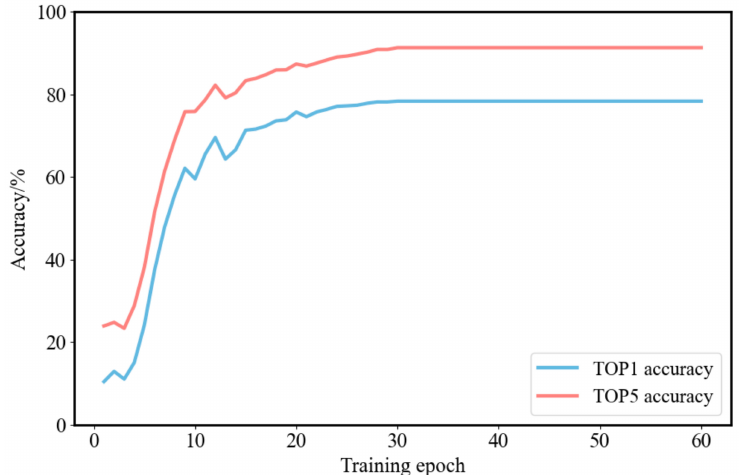
Figure 6. Change in trend for TOP1/TOP5 accuracy for the grassland-type recognition